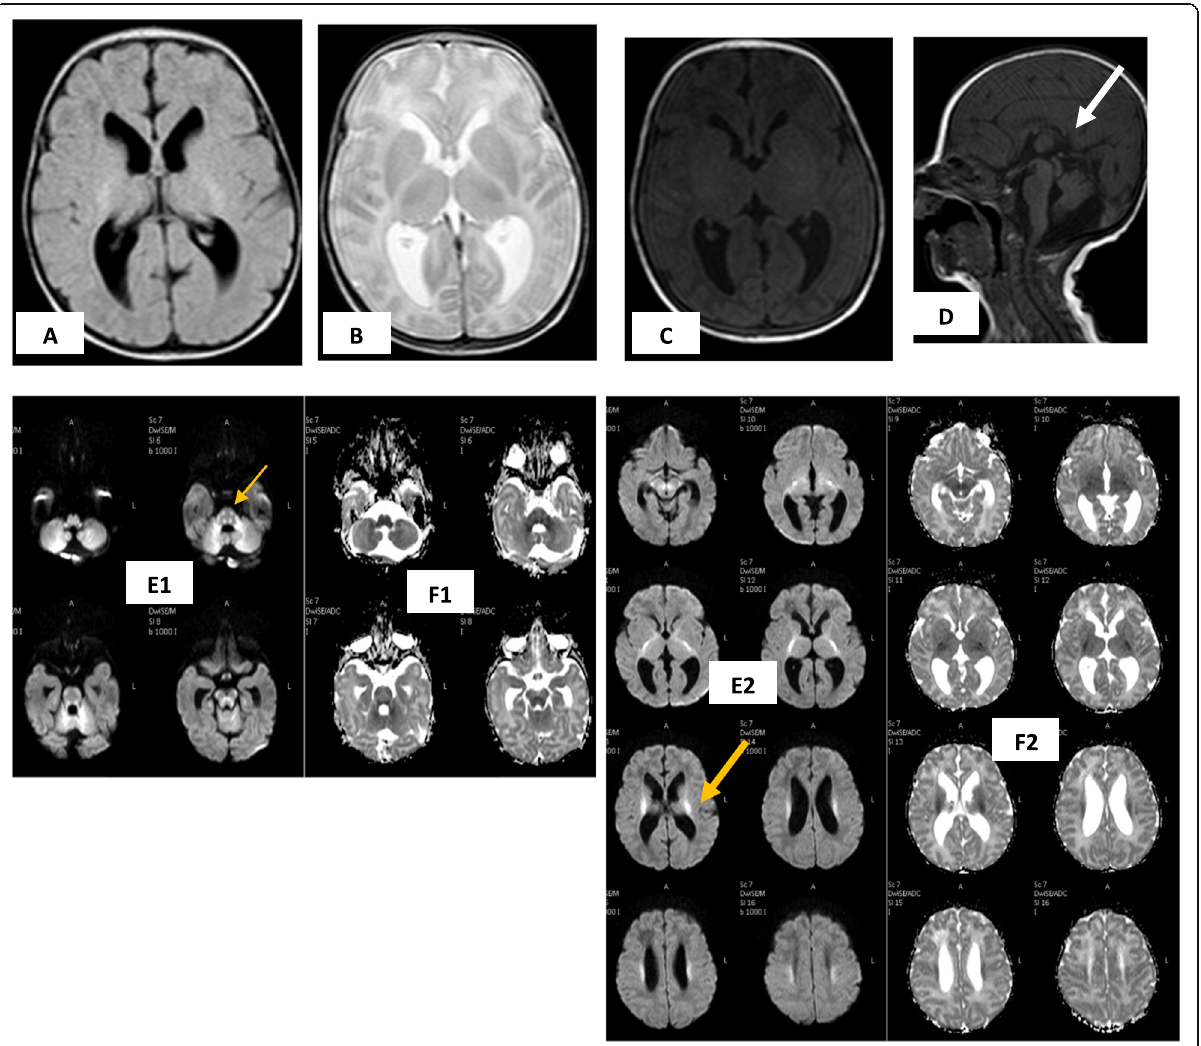
( C ), high at T2 ( B ) and FLAIR ( A ) with restricted diffusion (yellow arrow in E2 ) and small foci of restricted diffusion along the posterior aspect of the brain stem (yellow arrow in E1 ), middle cerebellar peduncles and the superior aspect of both cerebellar hemispheres (yellow arrow in E2 ) associated with corpus callosum hypogenesis (white arrow in D